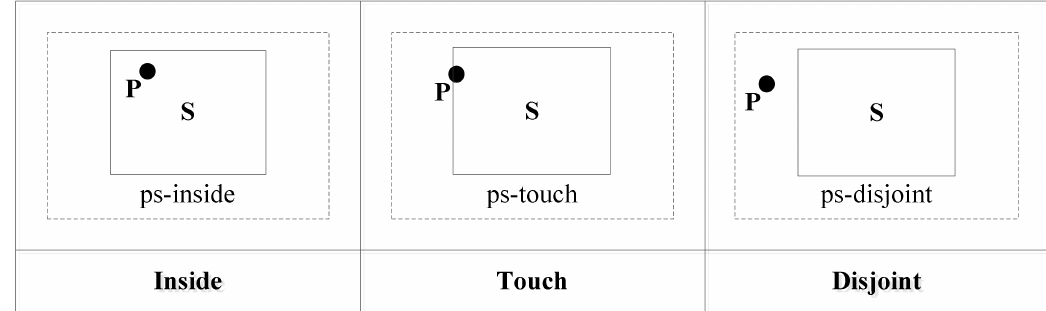
Figure 7. Topological relations between a point and a polygon.